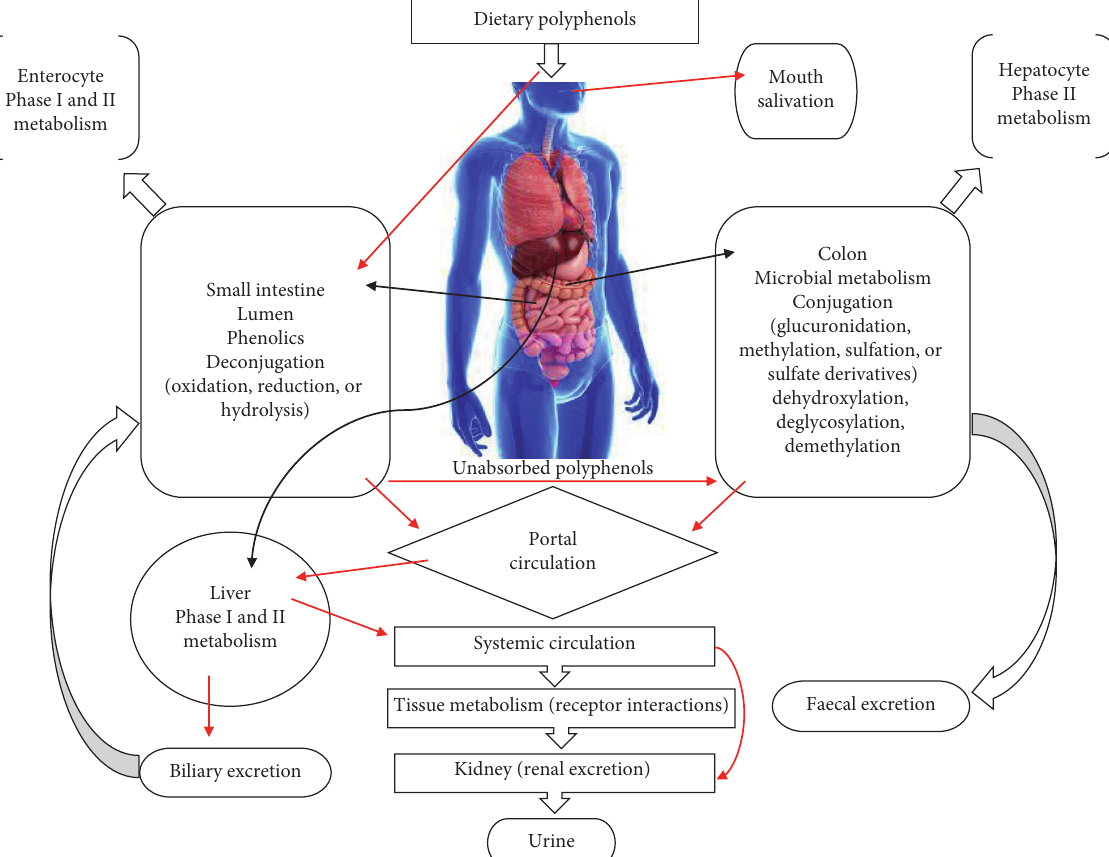
Figure 3: Metabolic route for polyphenol in the human gastrointestinal